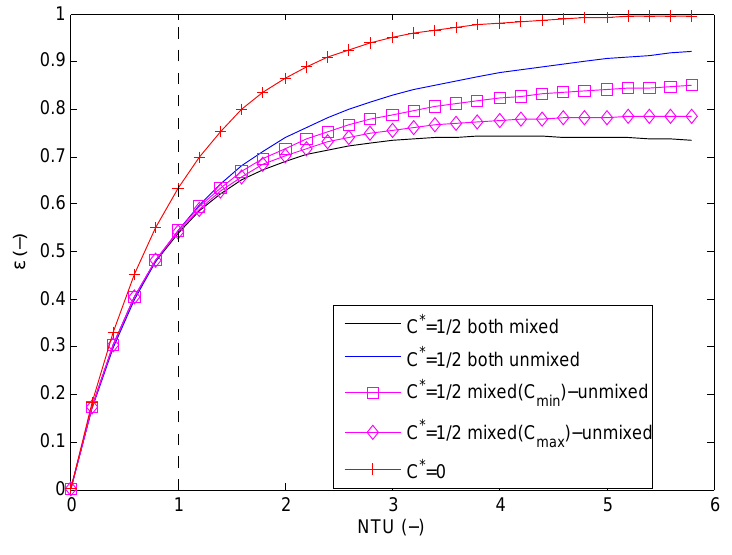
Figure 14. Effectiveness as a function of the number of transfer units (NTU) for mixed-unmixed compared to mixed-mixed and unmixed-unmixed flow